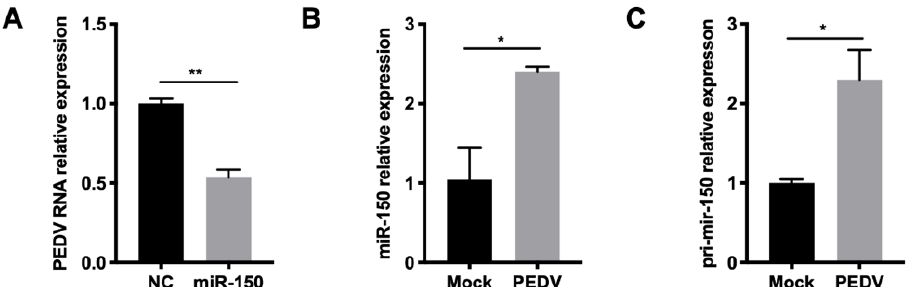
Figure 7. miR-150 has a broad-spectrum antiviral property for RNA virus. ( A , B ) Marc-145 cells were infected with PEDV at an MOI of 0.5 for 36 h. Total RNA was extracted, and qRT-PCR was used to analyze miR-150 and pri-miR-150 expression. ( C ) Marc-145 cells were transfected with miR-150 mimics or NC at a final concentration of 60 nM for 12 h, followed by infection with PEDV for 36 h at an MOI of 0.1. qRT-PCR was used to analyze PEDV RNA expression. The data are representative of three independent experiments (means ± SEM). p values were analyzed using a t -test. *, p < 0.05; **, p < 0.01.